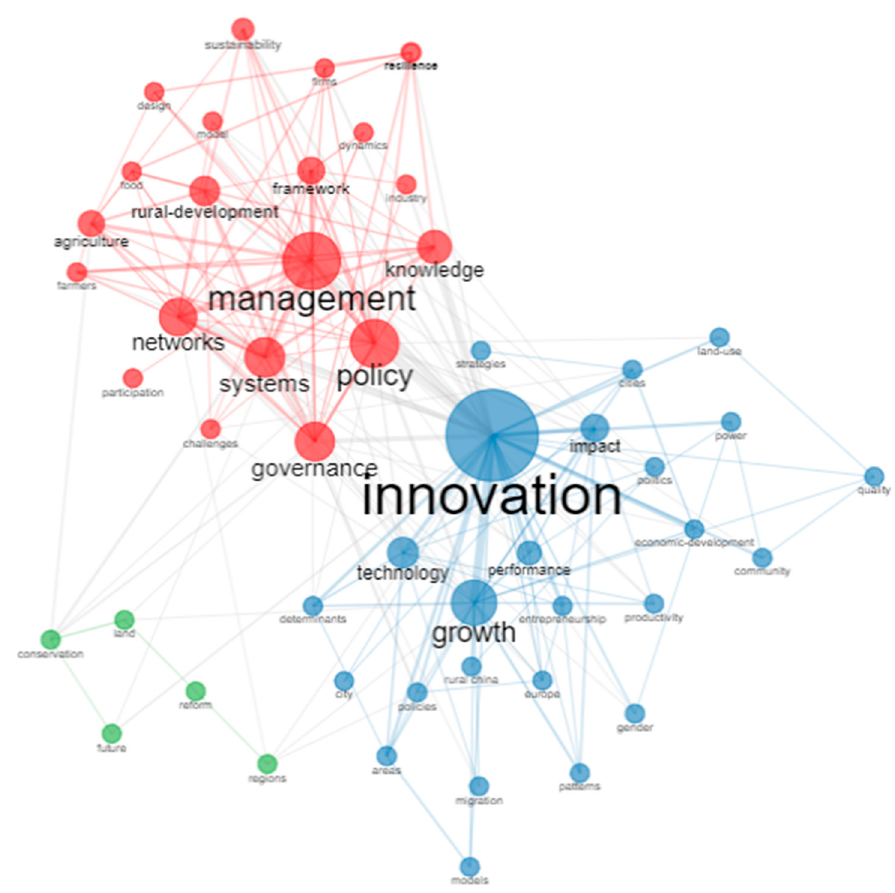
Figure 4. Co-occurrence network of the most frequent keywords.